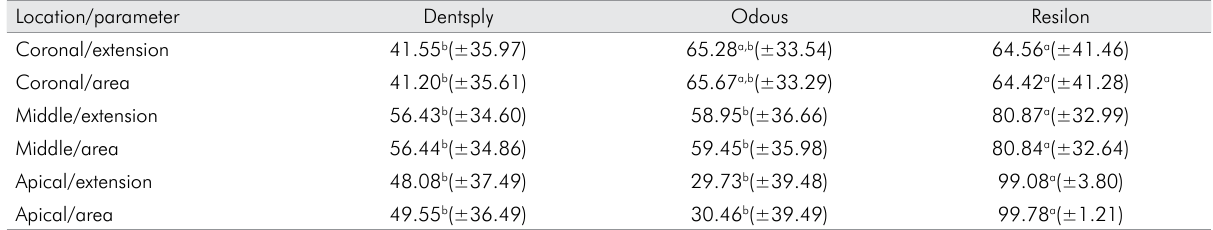
Table 1. Radiographic analysis of filling material penetration into simulated lateral canals made in each third (mean percentages). Location/parameter